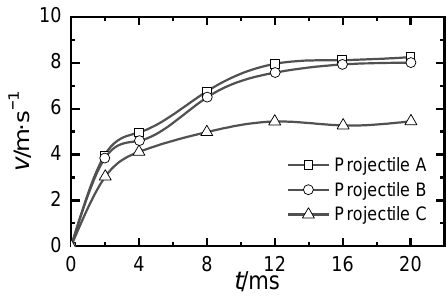
Figure 5. Projectile velocity ( p max = 9.9 MPa).